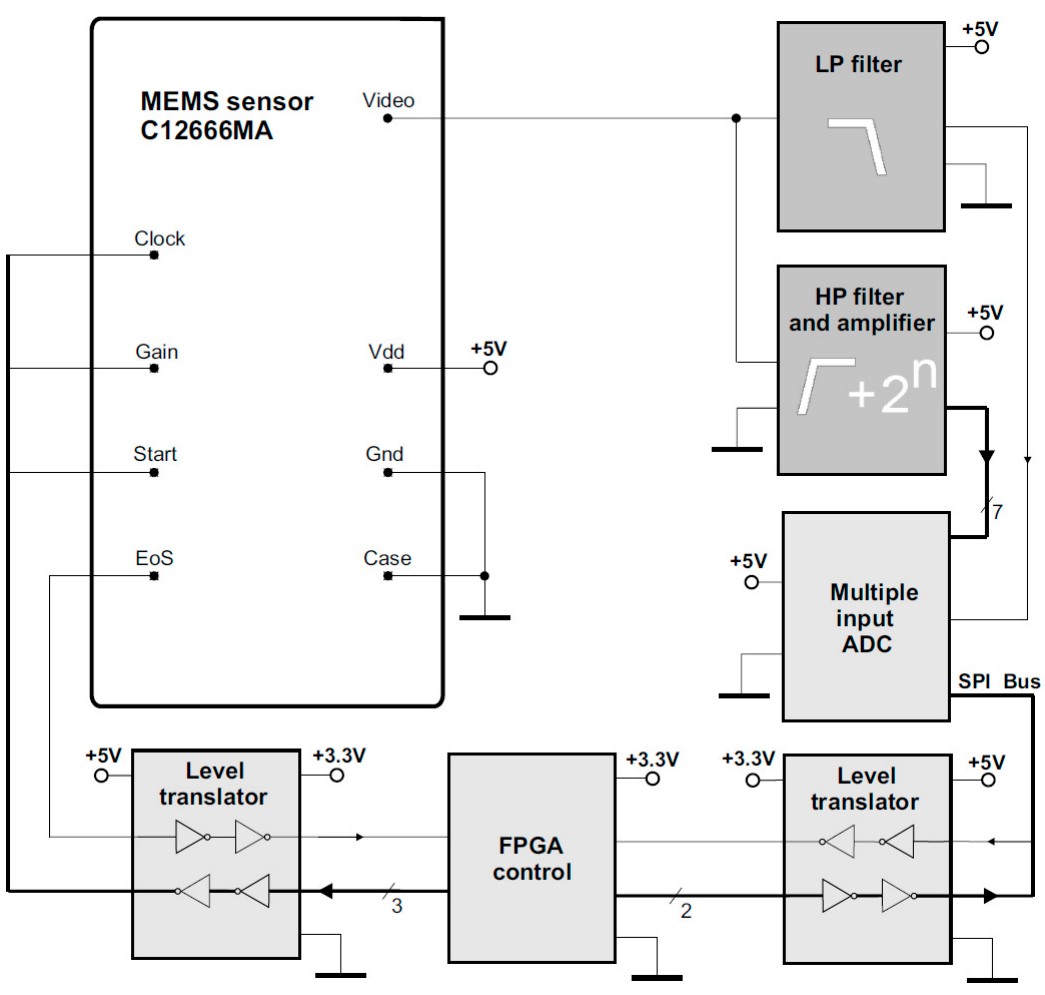
Figure 12. Block diagram of the new MEMS sensor circuit concept. The output signals for the DC component from the LP output and the 7-channel output signal of the HP variable component flow to the inputs of the AD converter. The detailed implementation of the amplifier filter for the variable component is shown in Figure 13.